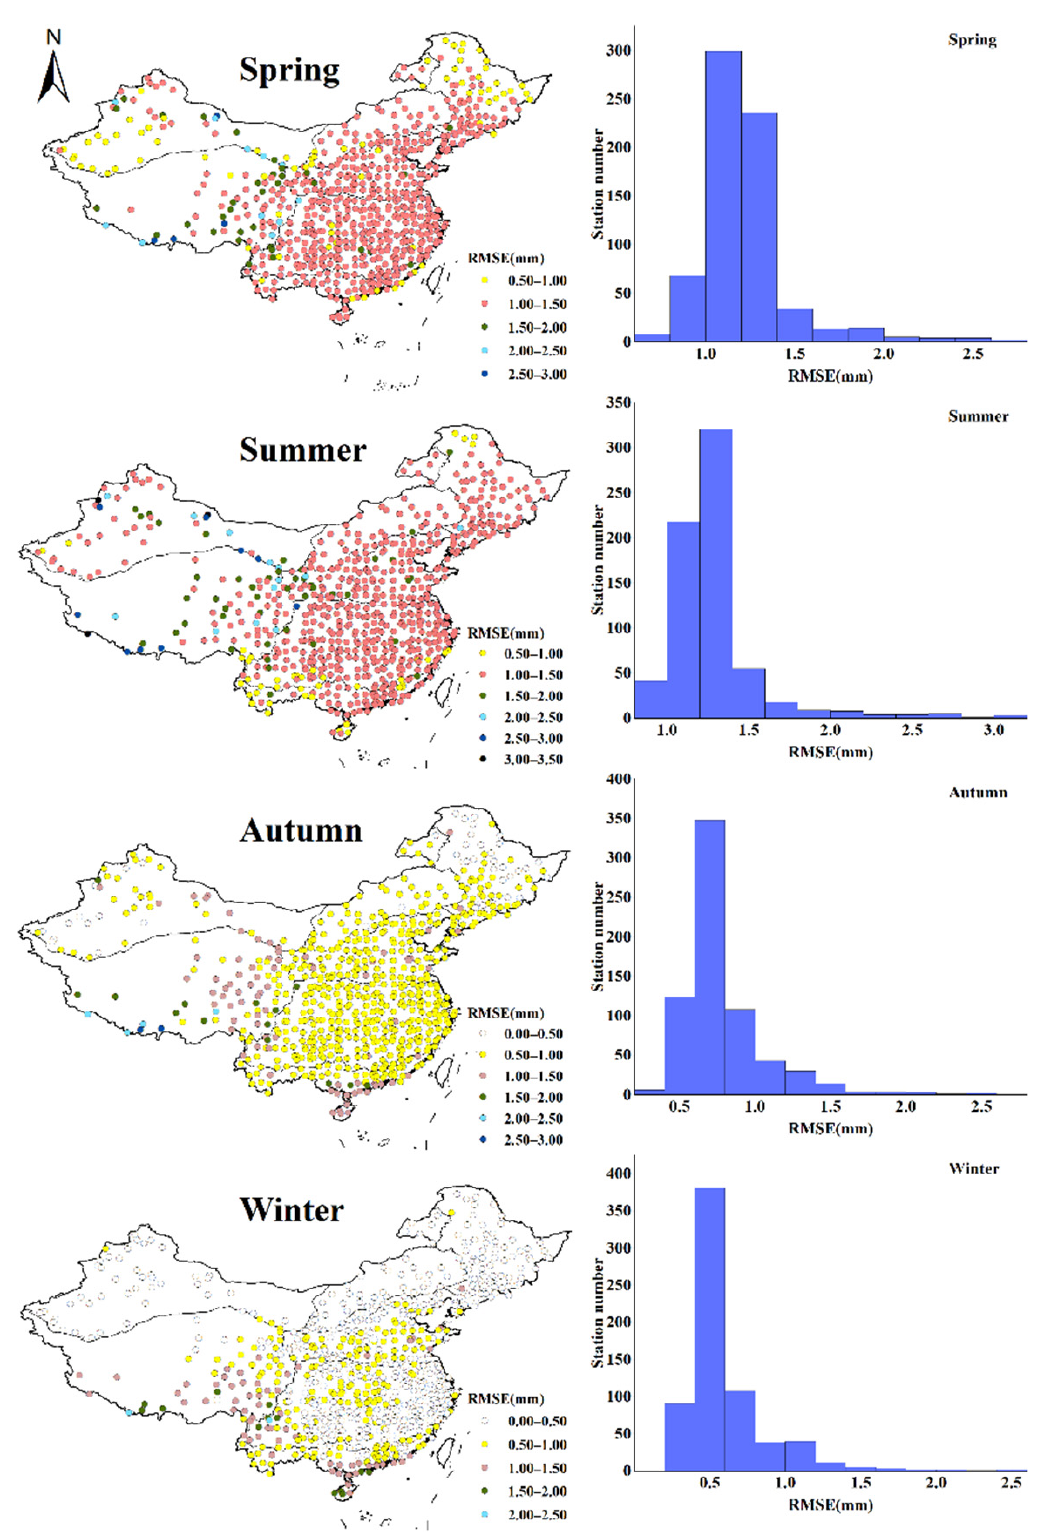
Figure 8. Seasonal RMSE of ET 0 calculated from CLDAS dataset.